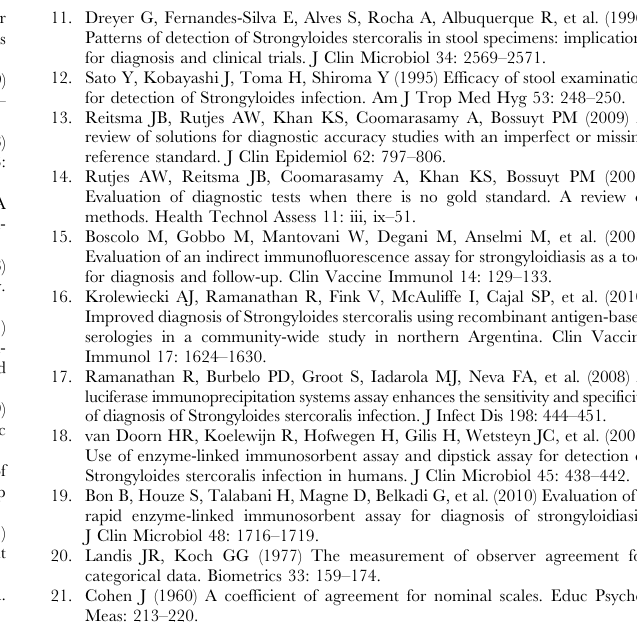
Figure S2 ROC curve for IVD ELISA (primary reference standard). Figure S3 ROC curve for Bordier ELISA (primary reference standard). Figure S4 ROC curve for NIE-LIPS (primary reference standard). Figure S5 ROC curve for IFAT (primary reference standard) (numbers correspond to titers, 3= 1/20 to 9= 1/1280). Figure S6 ROC curve for NIE-ELISA (primary reference standard). Table S1 STARD checklist for reporting of studies of diagnostic accuracy. Table S2 Test accuracy (composite reference standard) at different cut-off levels of the index tests.